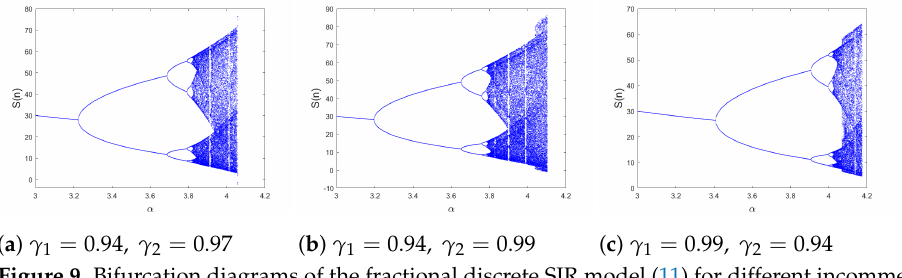
Figure 9. Bifurcation diagrams of the fractional discrete SIR model (11) for different incommensurate fractional-order values.